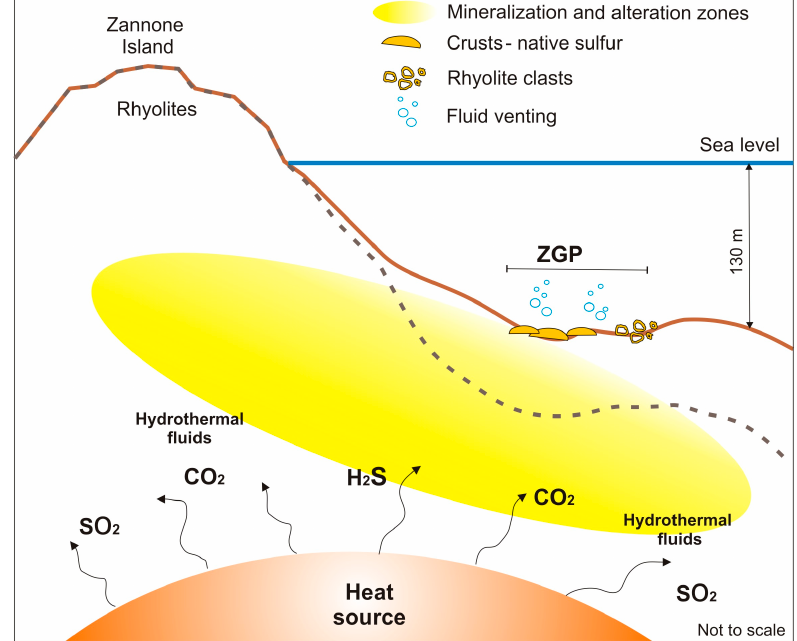
Figure 16. Sketch showing the possible occurrence of mineralization and hydrothermal alteration zones in the sub-surface of the ZGP. Dashed line indicates the probable top of the rhyolite substrata [16].